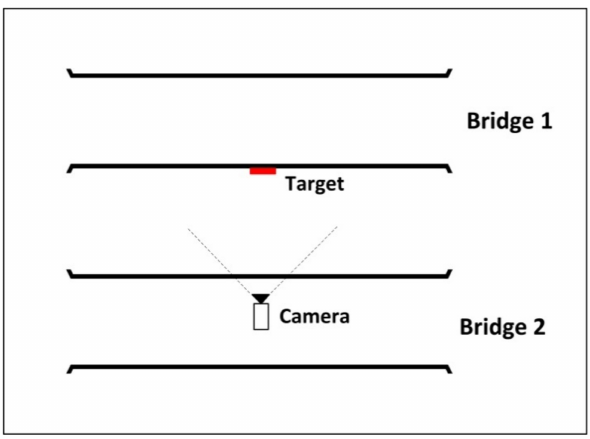
Figure 11. Configuration of image-based deformation measurement system.